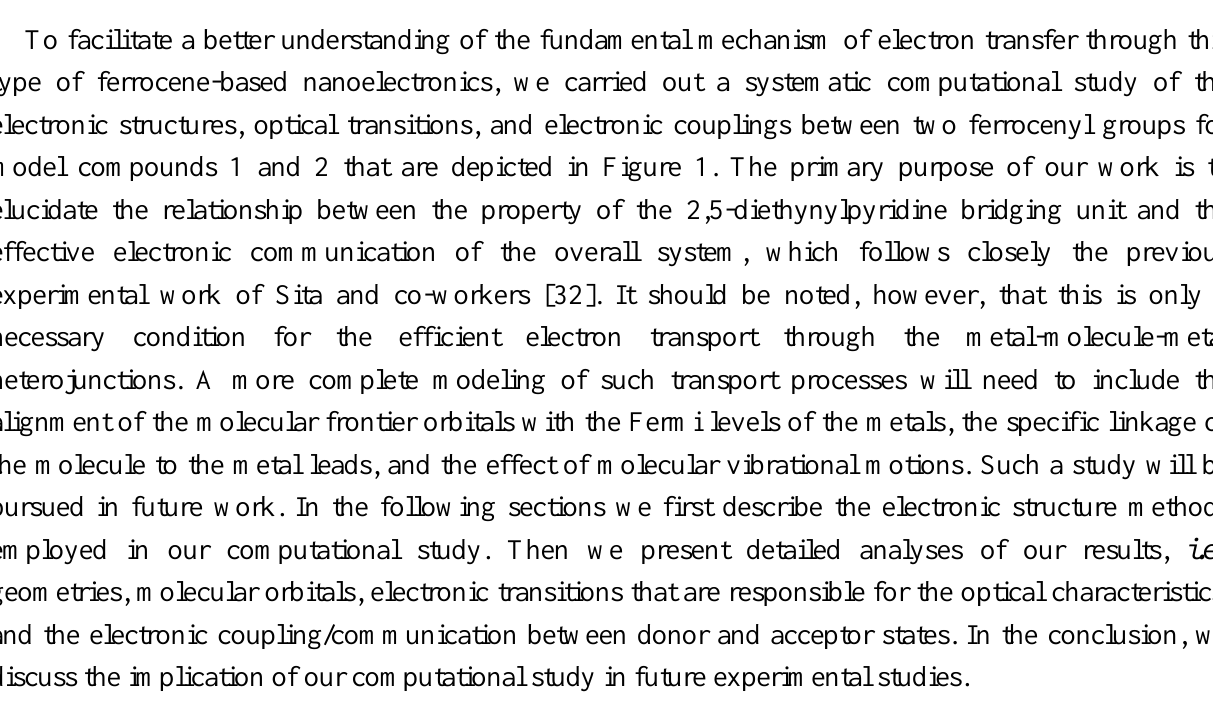
Figure 1. Structures of model compounds 1 and